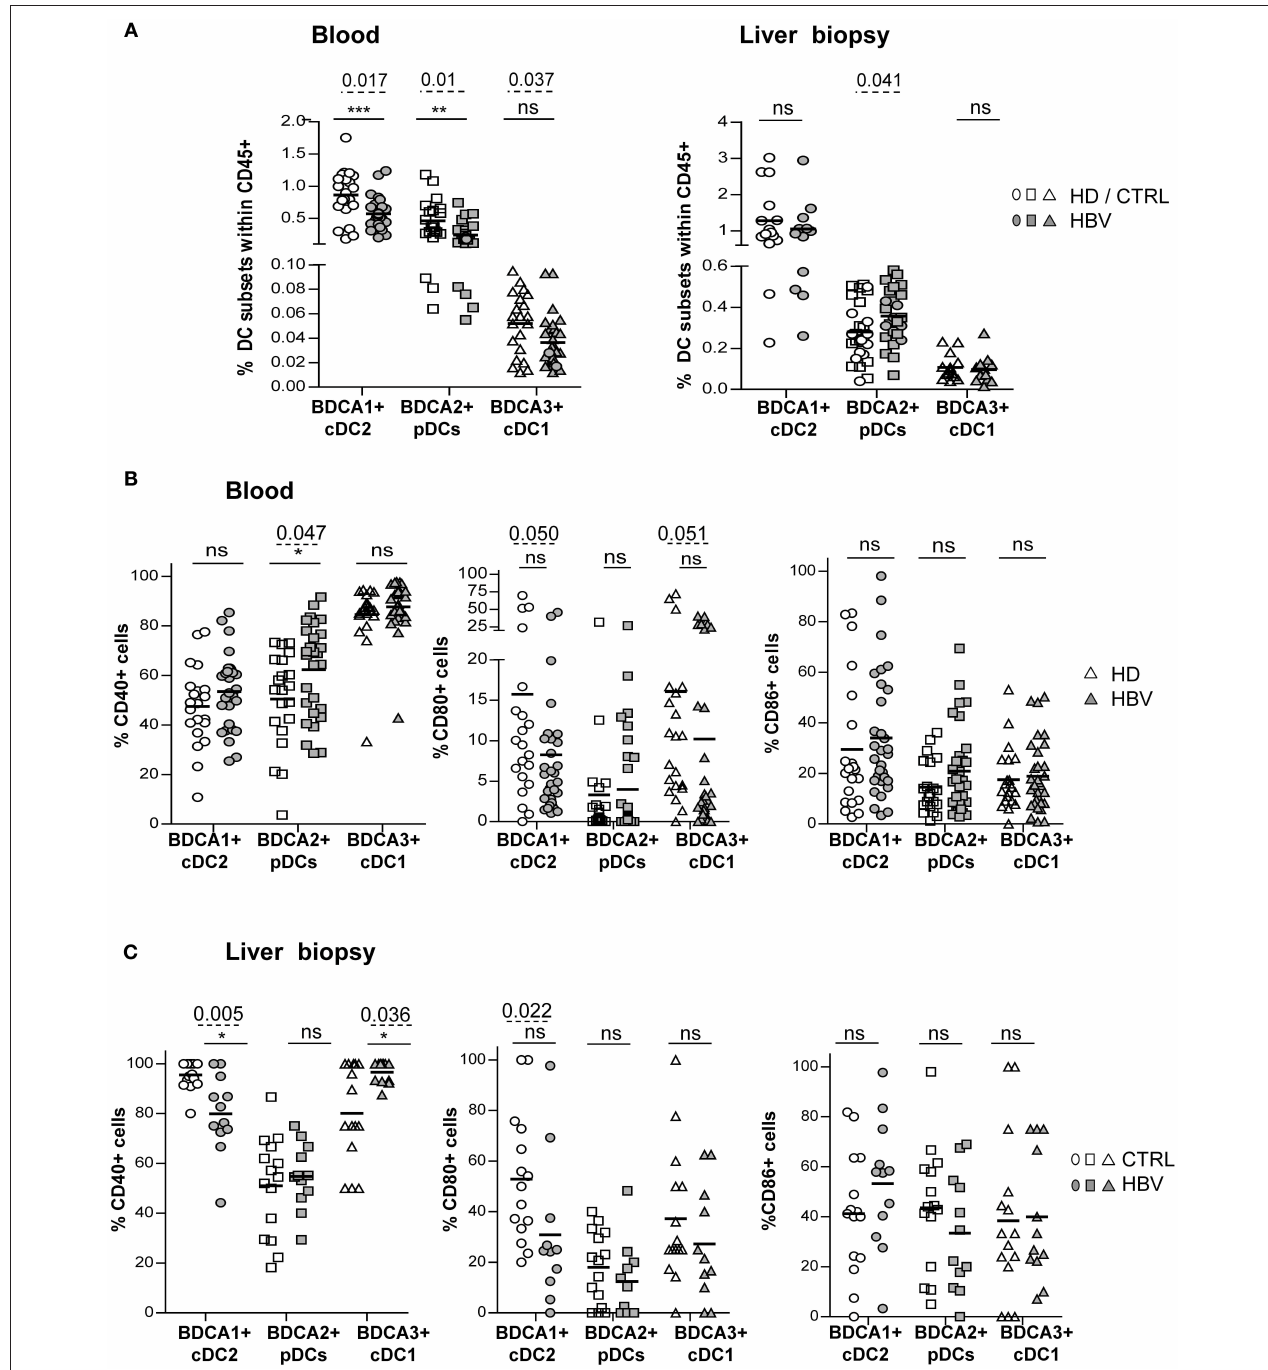
FIGURE 1 | Peripheral and intrahepatic DC subsets from chronic HBV patients displayed modulation of their basal activation status. DC subset’s frequencies and expression of co-activation molecules CD40, CD80, and CD86 were analyzed by flow cytometry on blood and liver DCs of chronic HBV patients and HD or non-viral infected controls. Frequency analyses of BDCA1 + cDC2, BDCA2 + pDCs, and BDCA3 + cDC1 within (A) PBMCs and LMNCs among living CD45 + cells. Open symbols, HD or non-viral infected controls (CTRL) (blood, n = 19–21; liver, n = 27 for pDCs, and n = 15 for cDCs); filled symbols, chronically HBV-infected patients (HBV) (blood, n = 28–30; liver, n = 25–27 for pDCs and n = 11 for cDCs). (B,C) Expression levels of the co-activation molecules CD40, CD80, and CD86 on (B) circulating and intrahepatic (C) cDC2, pDCs and cDC1 [ (B), open symbols, HD ( n = 21); filled symbols, HBV ( n = 29–31) or (C) open symbols, controls ( n = 15); filled symbols, HBV ( n = 11–12)]. Results are expressed as percentages of positive cells. Bars indicate mean. P -values were calculated using the 2-way-RM ANOVA test (straight line, * P ≤ 0.05, ** P < 0.01, *** P < 0.001) and Mann–Whitney test (dashed lines).